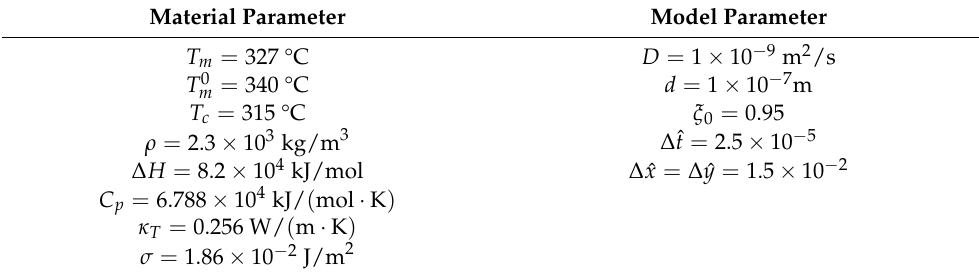
Table 1. Sets of the material parameter and model parameter used for the simulations of PTFE [42–44]. Material Parameter Model Parameter